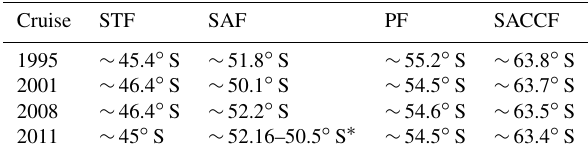
Table 3. Location of the ACC fronts south of Tasmania for each of the cruises following the definitions of Sokolov and Rintoul (2002) for hydrographic data. ∗ The range in the location of the SAF for the 2011 cruise could be related to a diversification of the PF or SAF into different jets (Sokolov and Rintoul, 2009) but also to crossing the meander of the front